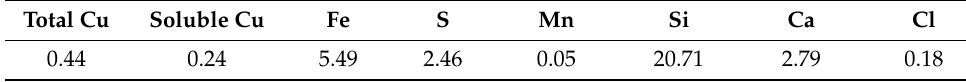
Table 1. Chemical composition of ore sample (%).